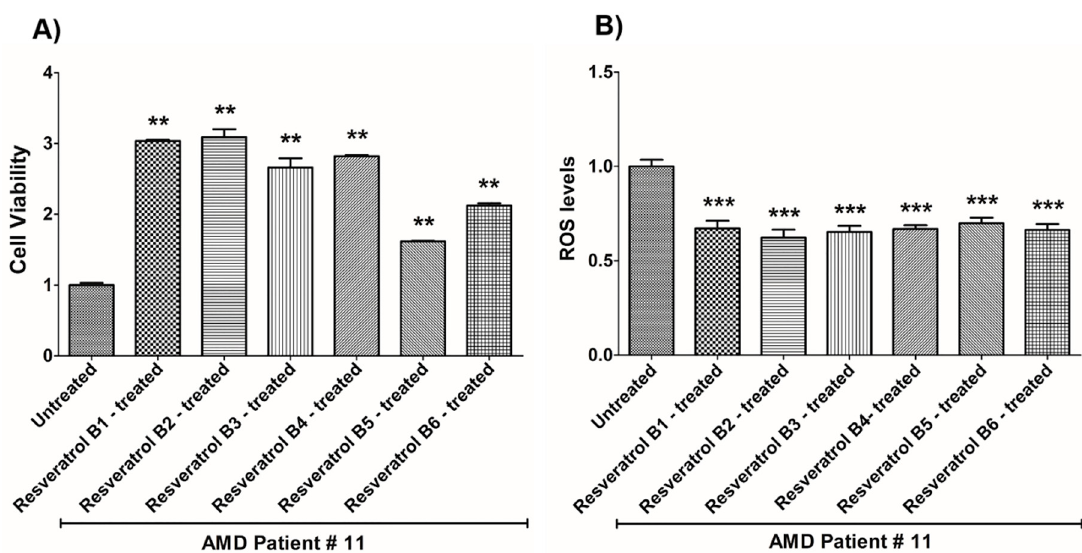
Figure 11. Effects of resveratrol formulations on cell viability ( A ) and ROS levels ( B ) in AMD patient